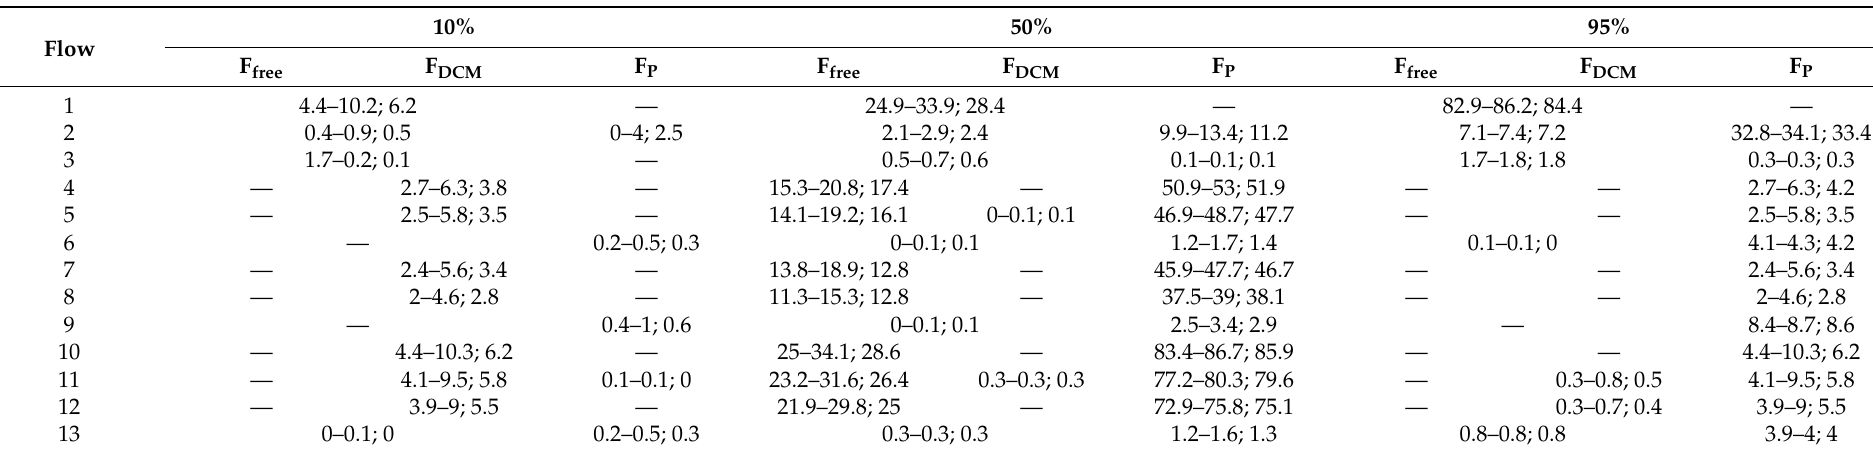
Table 5. Fate of benzo(a)pyrene in the modeled WWTP. Results are presented in g/day for 10%, 50%, and 95% percentiles. Combined values for flows 1, 2, 3, 6, 9, and 13 correspond to the aqueous phase (See Figure 1). Data shown as min–max;